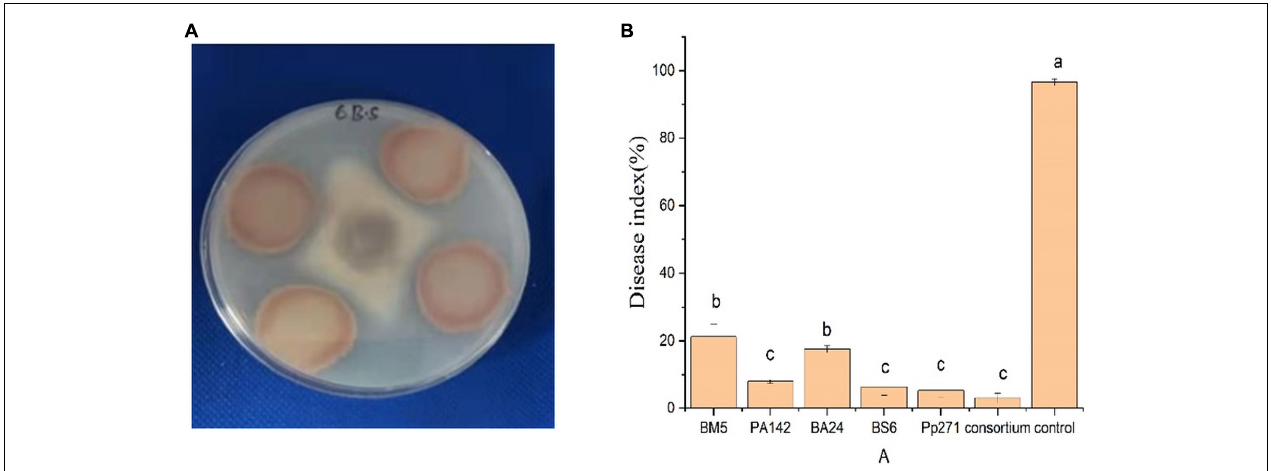
FIGURE 7 | (A) Antagonism effect of endophytic bacterial in vitro . Strain inoculated on PDA plates, incubated at 30 ◦ C for 2 days and then sprayed with the isolated bacteria. (B) Bioassay against F. oxysporum in the greenhouse condition, n = 6, significant difference is denoted by different letters ( P < 0.05).